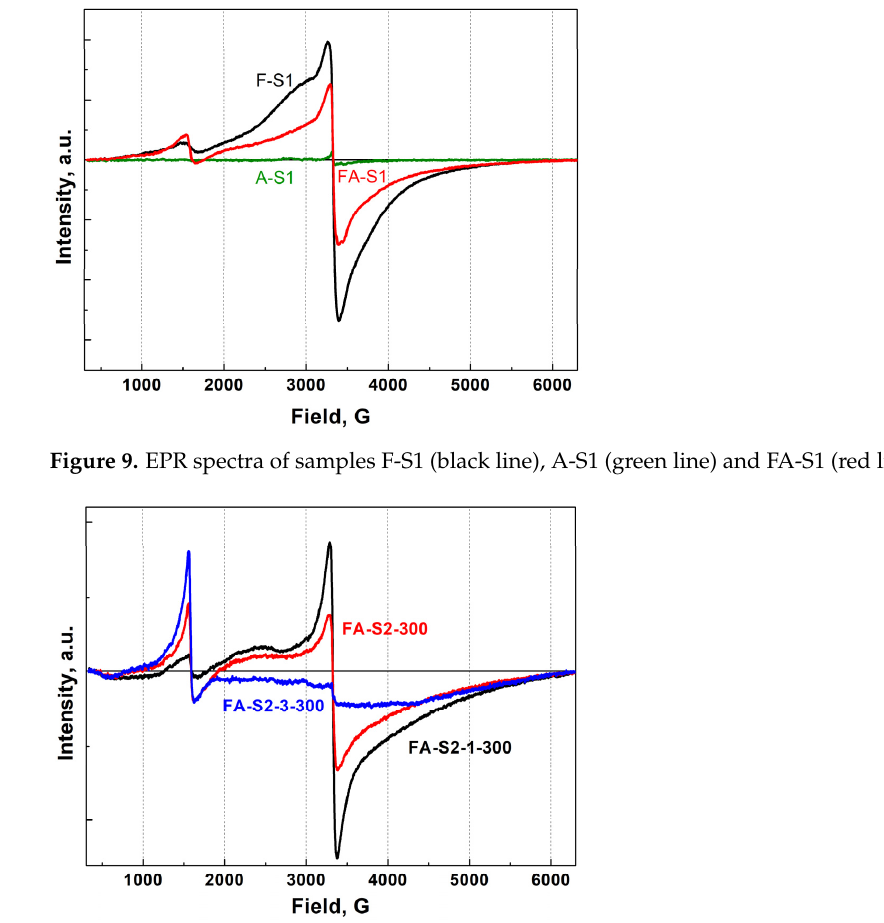
Figure 10. EPR spectra of samples FA-S2-1-300 (black line), FA-S2-2-300 (red line) and FA-S2-3-300 (blue line) at RT.